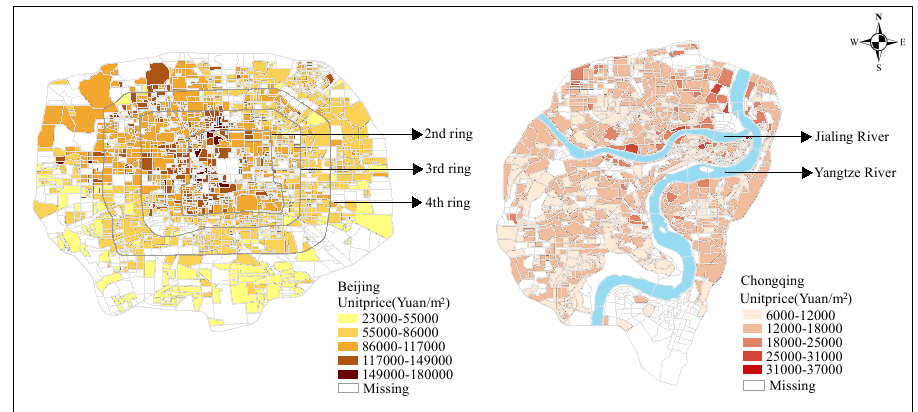
Figure 3. Spatial distribution of the house prices in Beijing and Chongqing.